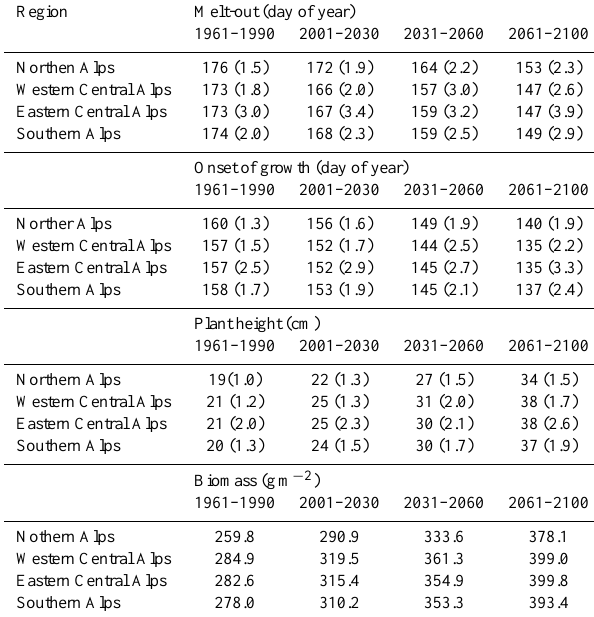
Table 1. Melt out ( V M ), onset of growth ( V G ) and plant height ( V P ) for the reference and future temperature conditions as pro- jected by the high resolution climate data ( T sim high , 1km resolu- tion, HadCM3-A2 scenario) for four selected biogeographic regions of the Swiss Alps. Given are the averages over the years